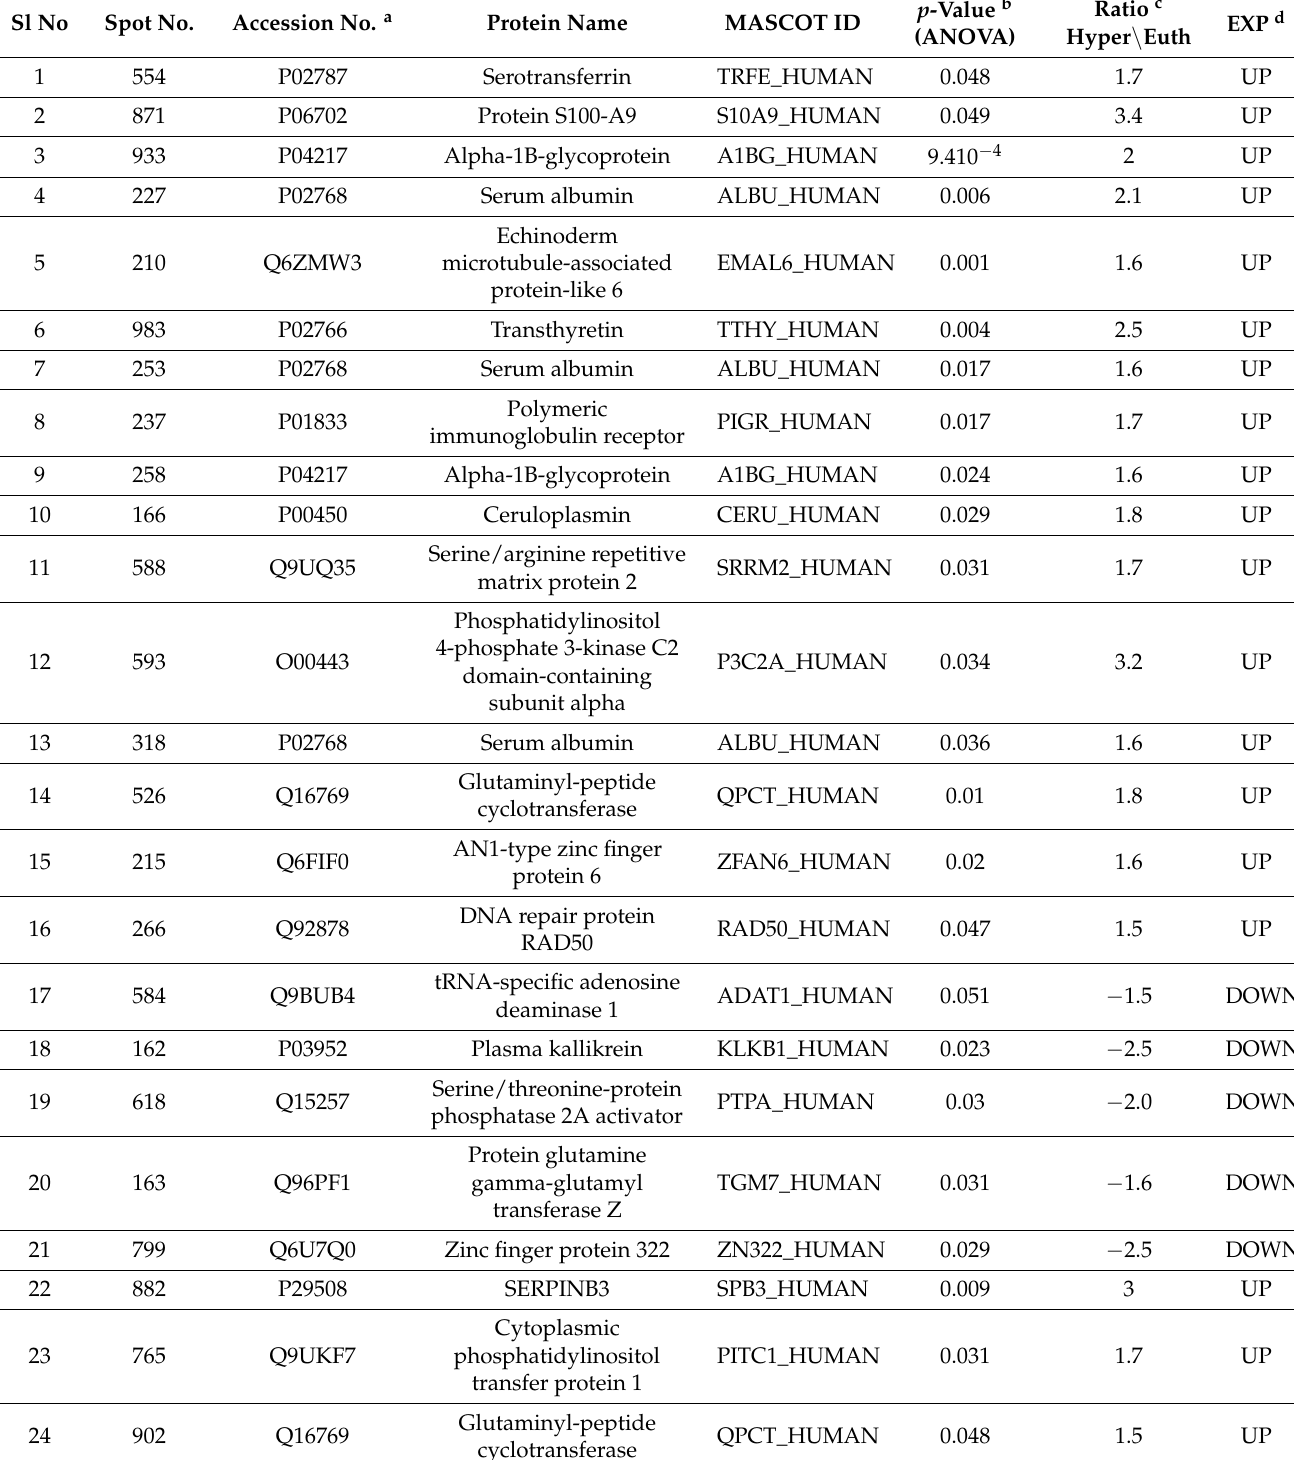
Table 2. Identified proteins, with changes in abundance of significantly differentially abundant proteins between hyperthy- roid and euthyroid states in urine samples. Table 2 shows values for the average ratio between the two states, with their corresponding levels of fold changes and one-way ANOVA ( p -value < 0.05) using 2D-DIGE. (Analysis type: MALDI-TOF; database: SwissProt; taxonomy: Homo